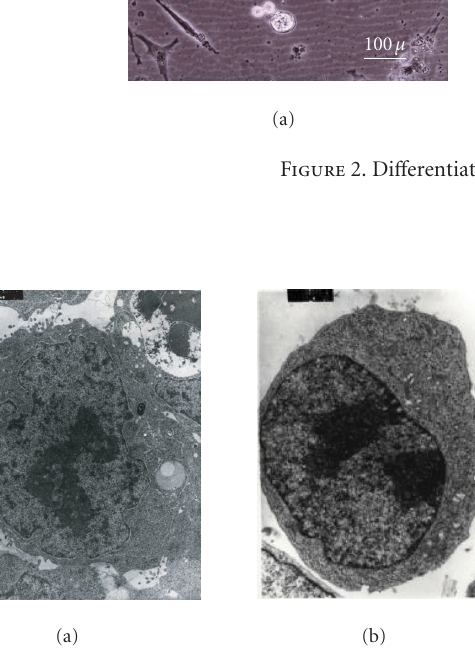
Figure 3. Electron micrographs of (a) ES cell and (b) osteogenic cell.